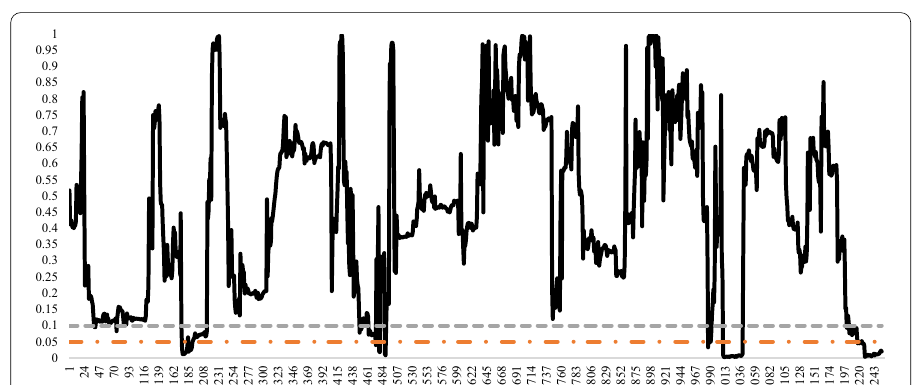
Fig. 12 The evolving p values of the AQ test statistic checked for the Ripple (XRP) in 100-day window